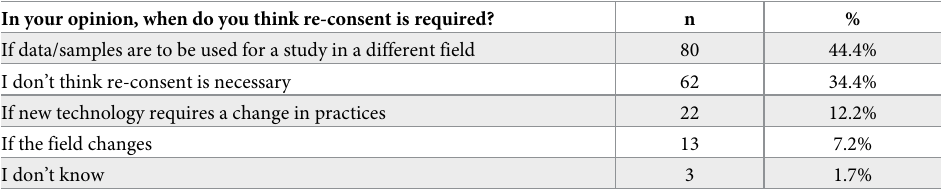
Table 7. Opinions on